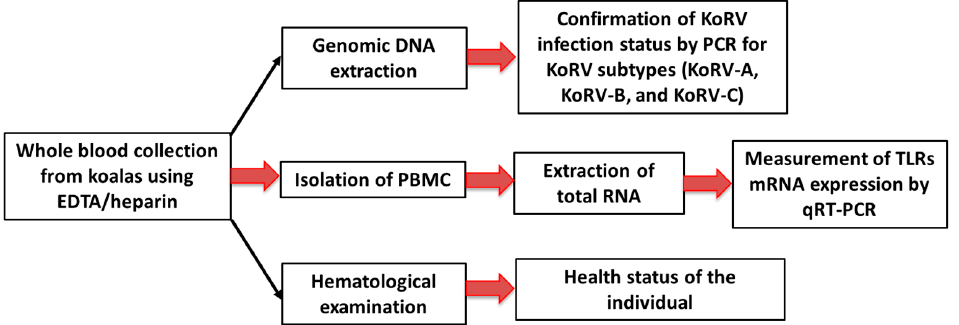
Table 1. Primers used for the detection of Koala retrovirus (KoRV) (subtypes) and toll-like receptors (TLRs) gene expres-